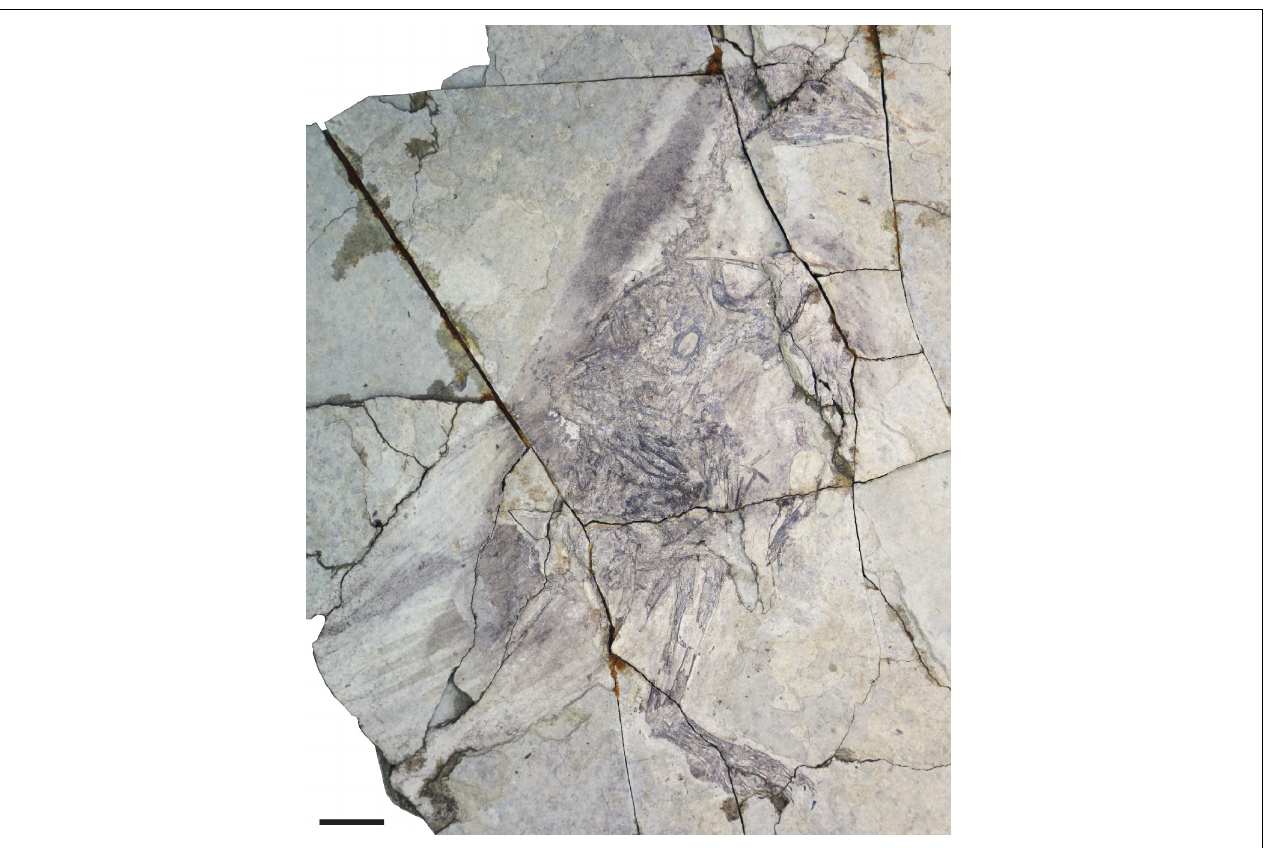
FIGURE 2 | Confuciusornis sp. STM13-162 (main slab). Scale bar equals two